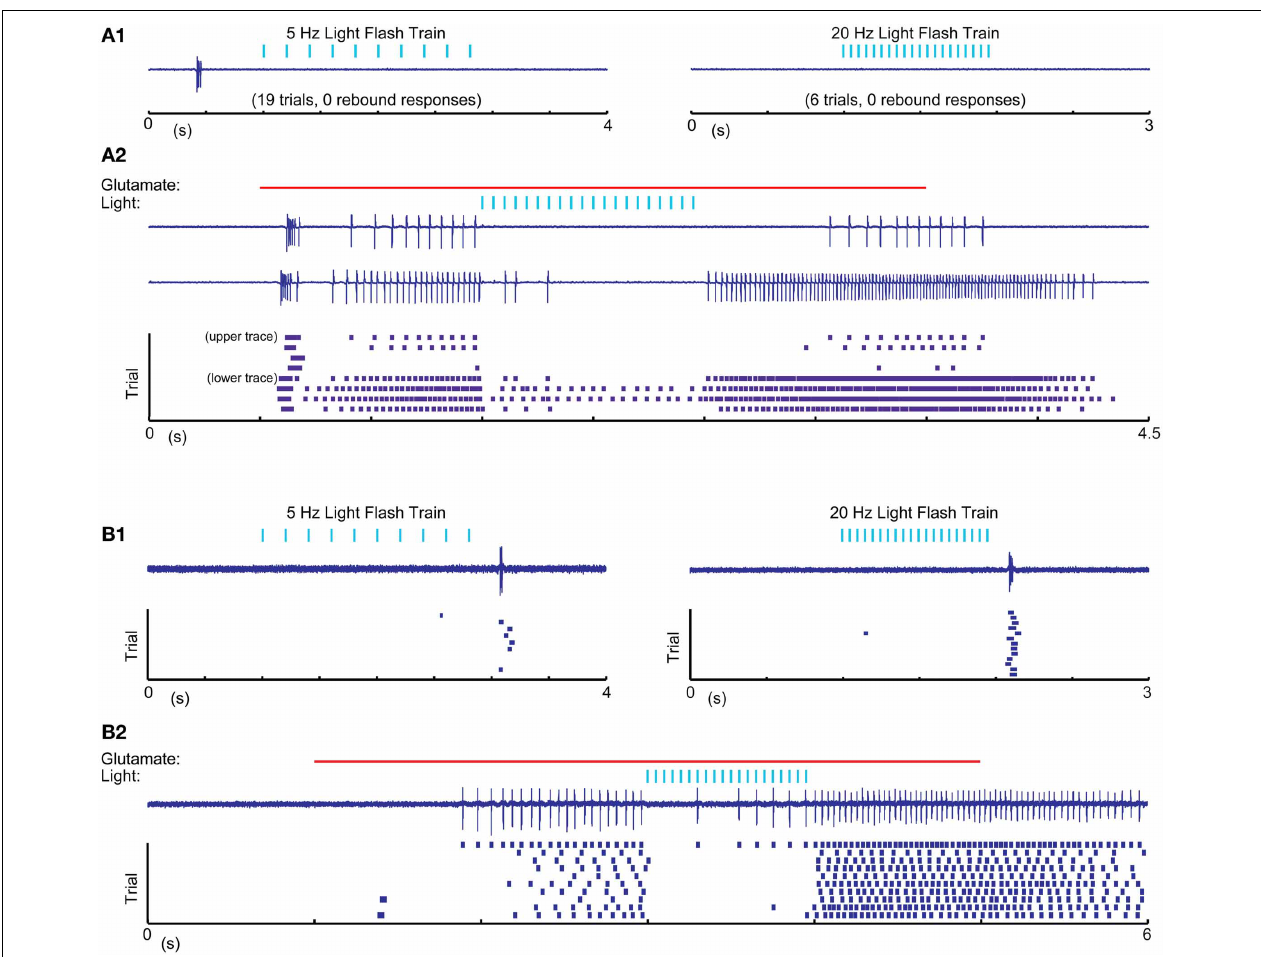
FIGURE 7 | Cell attached recordings with glutamatergic excitation and optical nigral input stimulation. (A1,B1) 5Hz 10ms and 20Hz 5ms light pulse trains result in LTS rebounds in one cell (B) , but not another (A) . Purple traces show recordings of extracellular spike currents and raster histograms below show spike times for repeated application of the same stimulus combination. (A2,B2) The same optical stimuli delivered during a 4s 0.5mM glutamate application result in pronounced spike pauses of